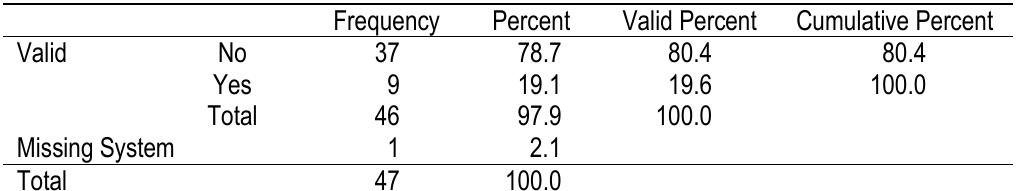
Table 4. “I think that practical work can be replaced by computer simulations or other virtual components that do not require a face-to-face class”